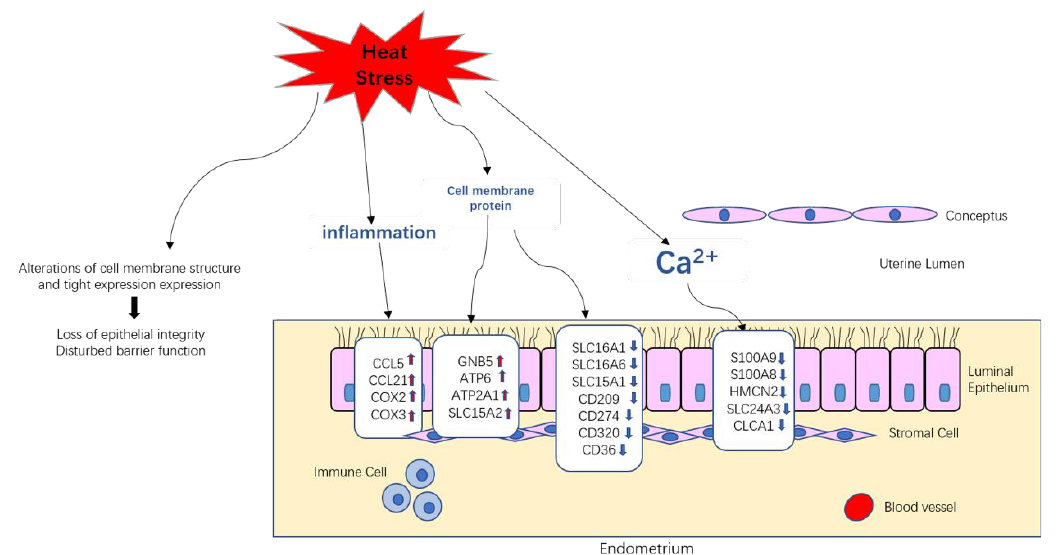
Figure 9. Model of heat-stress effects on endometria in pigs during embryo implantation.